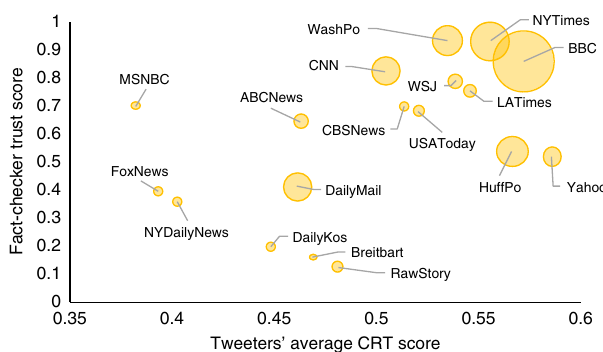
Fig. 2 Fact checker trust score of shared news sources versus average CRT score of users. Each dot represents an outlet shared by users in our sample on Twitter. The size of the dots represents the number of observations. For clarity, we show outlets that have been shared at least 50 times by the